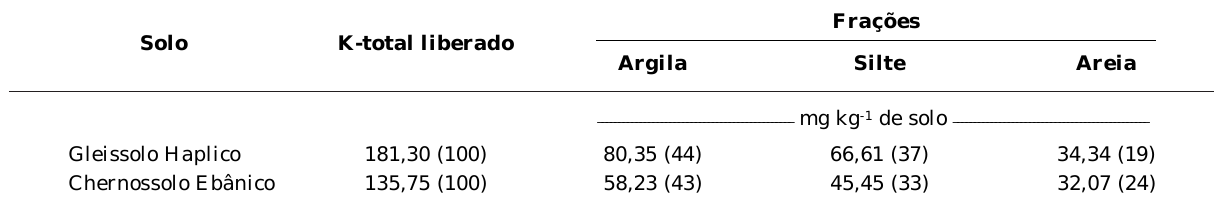
Entre parênteses expressa-se a percentagem em relação ao total liberado.